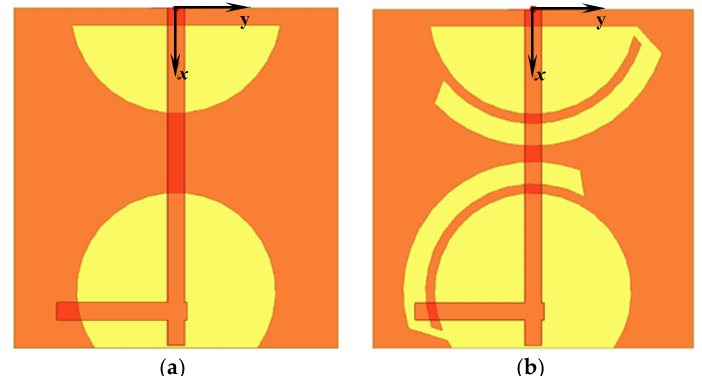
Figure 2. Design steps of the proposed antenna ( a ) slot antenna without adjunct arc-shaped slots and ( b ) slot antenna with adjunct arc-shaped slots.